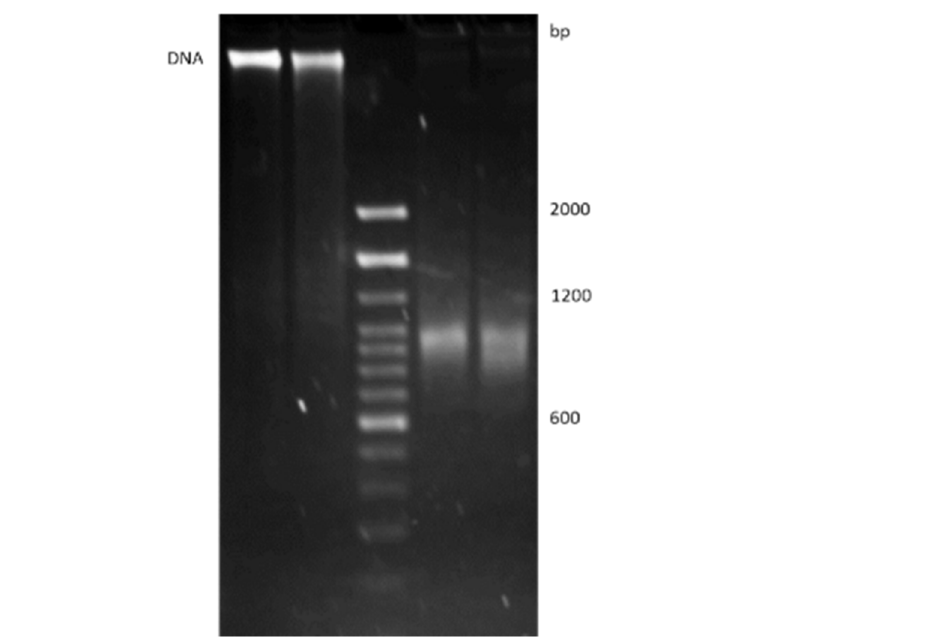
Figure 7. Genomic DNA analysis following BBR and LED stimulation. Agarose gel electrophoresis analysis in T98G cells as untreated (NT), exposed to LED stimulation (LED), BBR (200 μ g/mL for 4 h) administration and with the combined LED+BBR treatment evaluated at 24 h p.t. After cells trypsinization, genomic DNA was extracted and quantified using Qubit DNA HS kit (Invitrogen): 180 ng of each DNA was loaded onto a 2% agarose gel and visualized after 5 h running at 25 V. M is the 100 bp DNA ladder (Invitrogen).